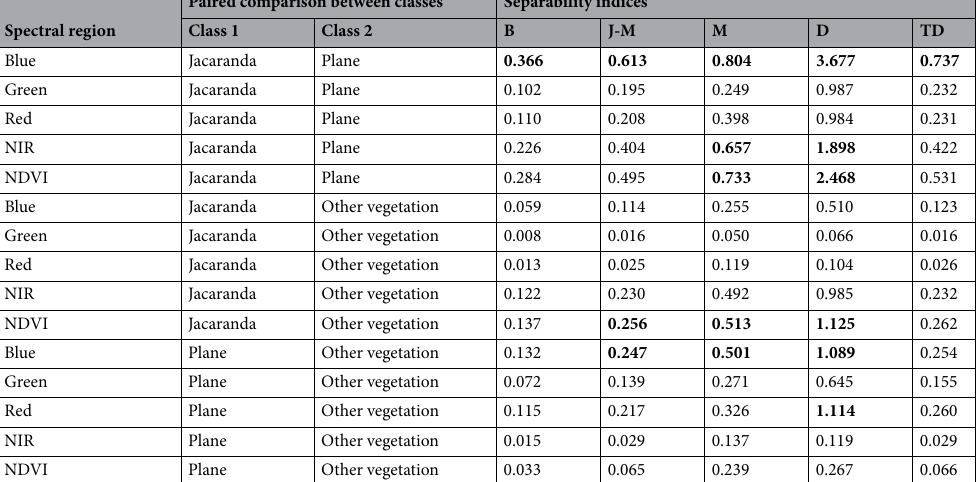
Table 1. The performance analysis of the four spectral bands (Blue, Green, Red and NIR) and NDVI index of SPOT 6 data to effectively discriminate between the pure spectral pixels of Jacaranda mimosifolia, and Platanus × acerifolia (London Plane) and other vegetation type using the separability measurements, Bhattacharyya distance, Jeffries-Matusita distance, M-statistic, Divergence and Transformed Divergence. NB, numbers in bold indicate the highest separability values achieved by each of the separability